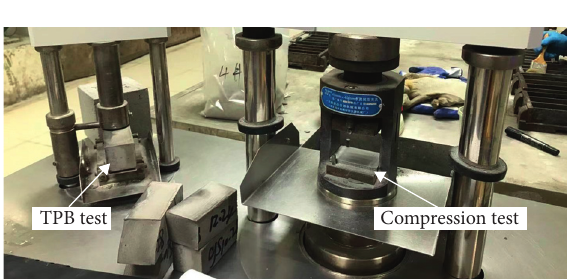
Figure 2: TPB test and compression test setup.